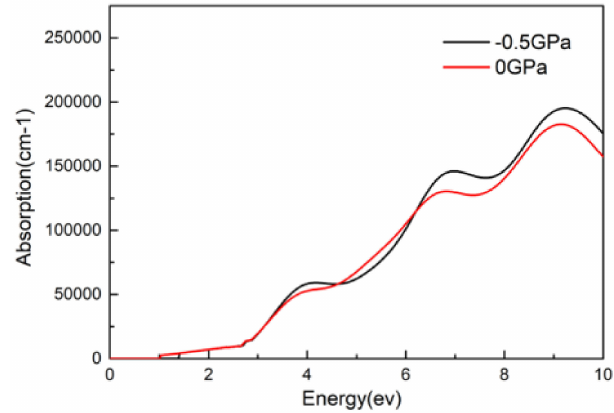
Figure 8. The conductivity of CsGeI 3 of ( a ) real and ( b ) imaginary under the pressure of 0 GPa and − 0.5 GPa.